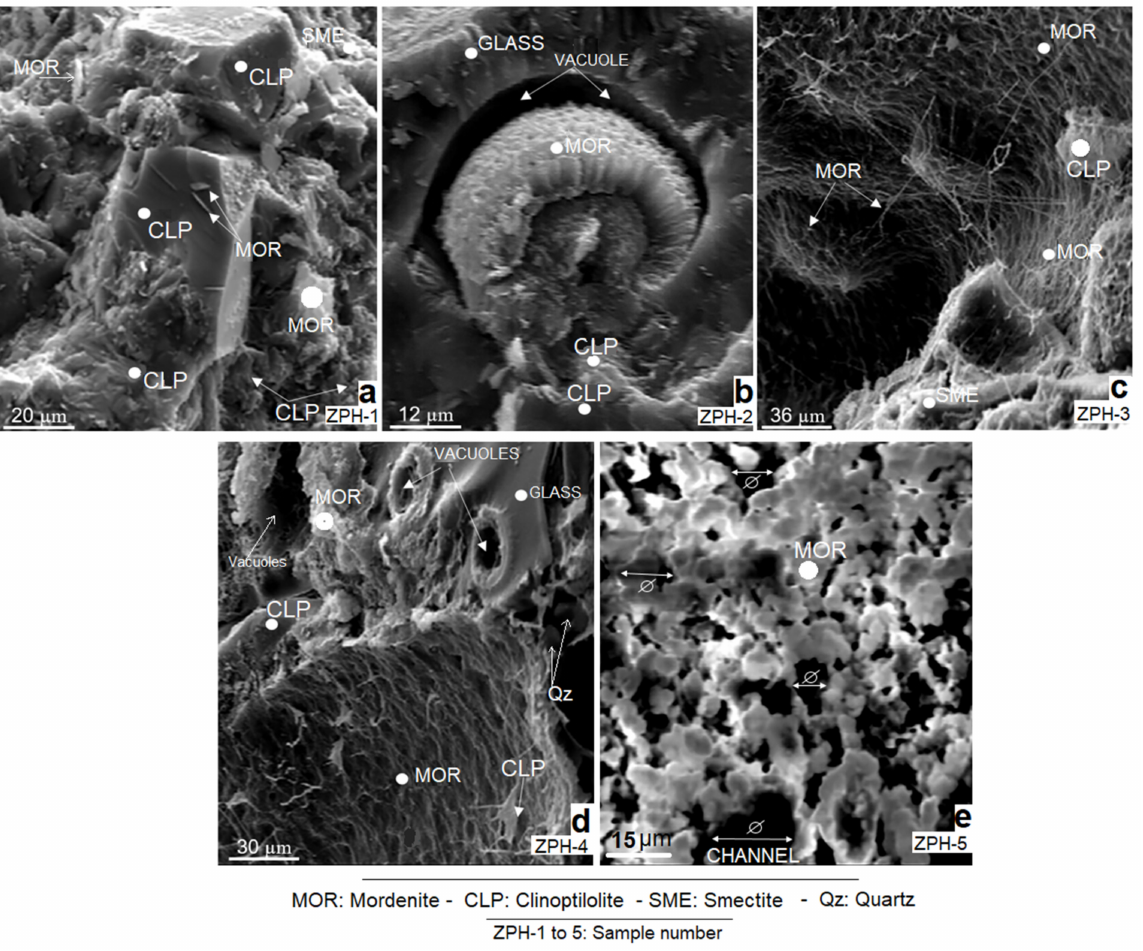
Figure 3. SEM micrographs of natural mordenite-clinoptilolite samples: ( a ) sample ZPH-1; ( b ) sample ZPH-2; ( c ) sample ZPH-3; ( d ) sample ZPH-4, and ( e ) sample